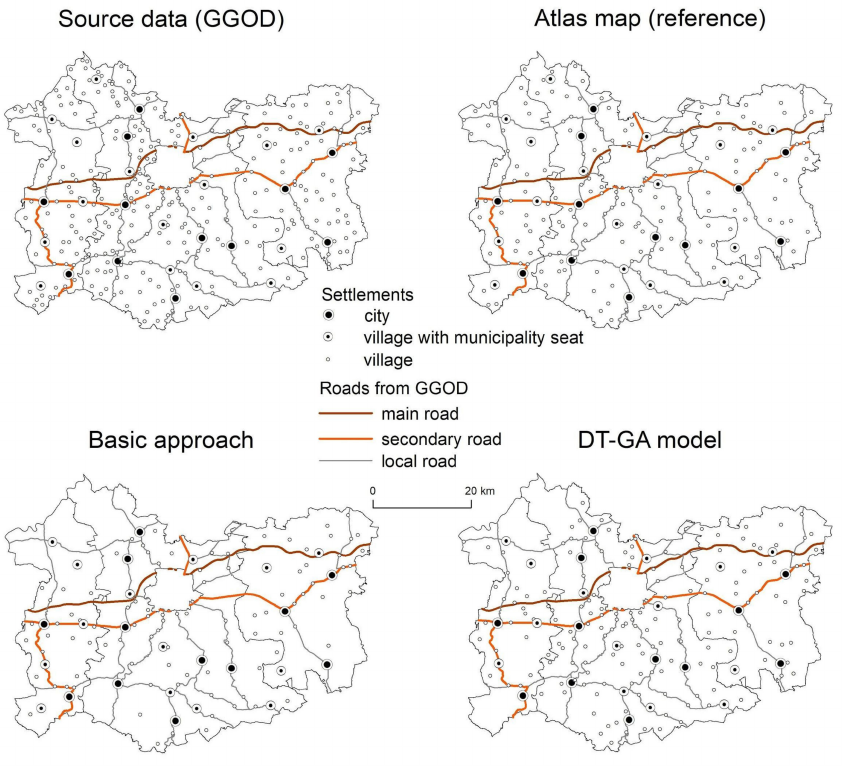
Figure 3. Maps of Brzeski, Tarnowski and D˛ebicki districts; group 1.